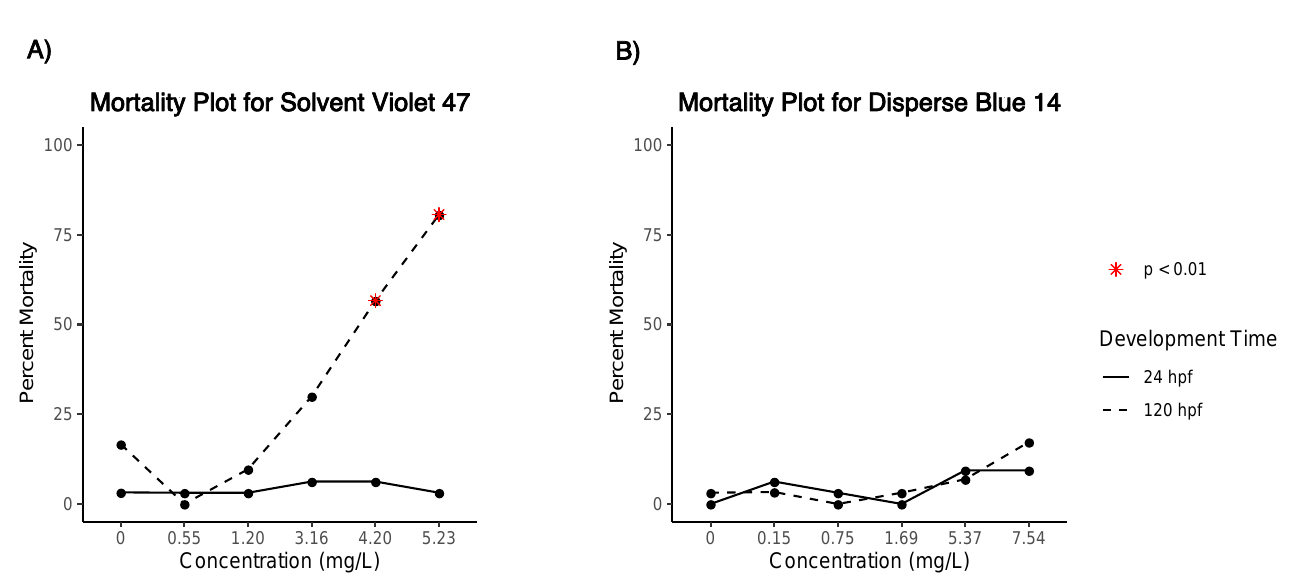
Figure 1. Summary of mortality at 24 h post fertilization (hpf) and 120 hpf in ( A ) Solvent Violet 47 and ( B ) Disperse Blue 14 treatment groups. * Indicates statistical significance ( p < 0.01) against the control (0 mg/L). Table 1. Lowest Effect Levels (LELs) and Fisher’s Exact Test (P) p -values for morphological endpoints. (-) indicate no significance at any concentration. At 24 hpf, embryos were assessed for mortality (MO24), developmental progression (DP24), spontaneous movement (S24), and notochord distortion (NC24). Additionally, at 120 hpf, embryos were assessed for mortality (MORT), and morphological malformations, including yolk sac edema (YSE), bent body axis (AXIS), eye (EYE), snout (SNOU), jaw (JAW), otic (OTIC), pericardial edema (PE), brain (BRAI), somite (SOMI), pectoral fin (PFIN), caudal fin (CFIN), circulation (CIRC), pigmentation (PIG), trunk length (TRUN), swim bladder (SWIM), notochord distortion (NC), and alterations in touch response (TR). Solvent Violet Endpoint